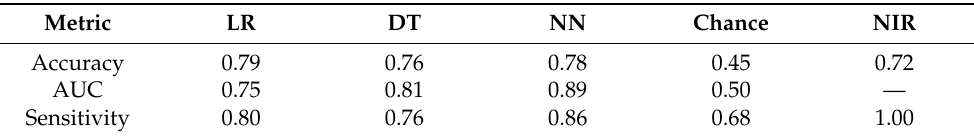
Table 9. Model metric comparisons, as measured on a 30% holdout dataset (DT and LR) or a 15% holdout dataset. NIR: no information rate, or the metrics that result from always predicting the majority class of “THC user.”